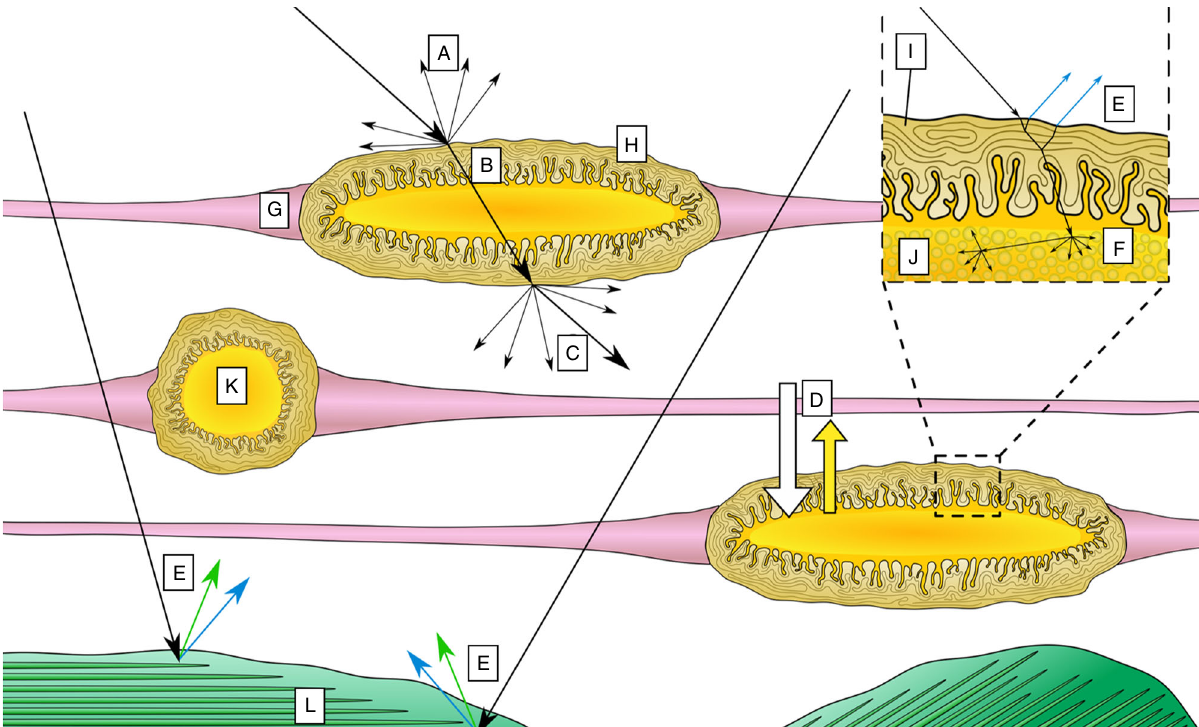
Fig. 8 Predicted optical effects within and around the chromatophore organs. The associated optical phenomena proposed based on our current and previous (see ref. 17 ) fi ndings are represented as a back scatter, b refraction, c forward scatter, d absorption (of non-yellow wavelengths), e multilayer interference, and f diffuse scattering, where g represents the radial muscle fi bers; h represents the sheath cells; i represents the cytoplasm of the sheath cells; j represents individual granules; k represents the a collection of granules within the yellow chromatocyte; and l represents an iridophore, deeper in the dermis. For simplicity, only yellow colored chromatophores are illustrated